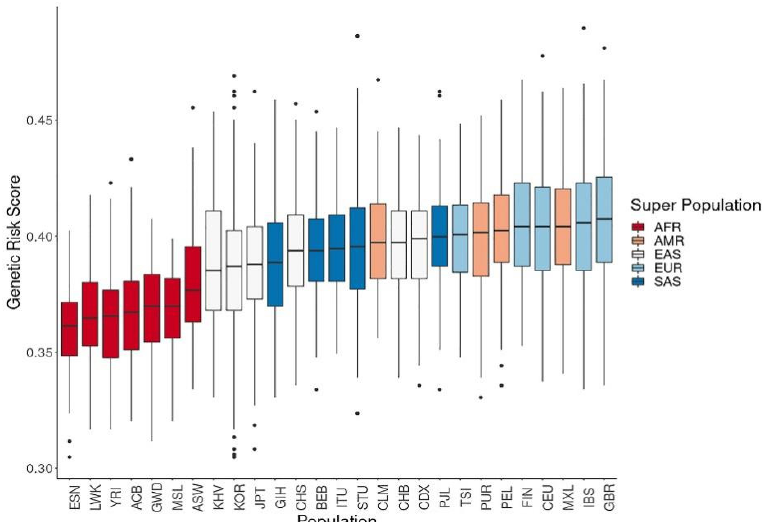
Figure 3. Genetic risk score calculations of vitamin D concentration using related single-nucleotide